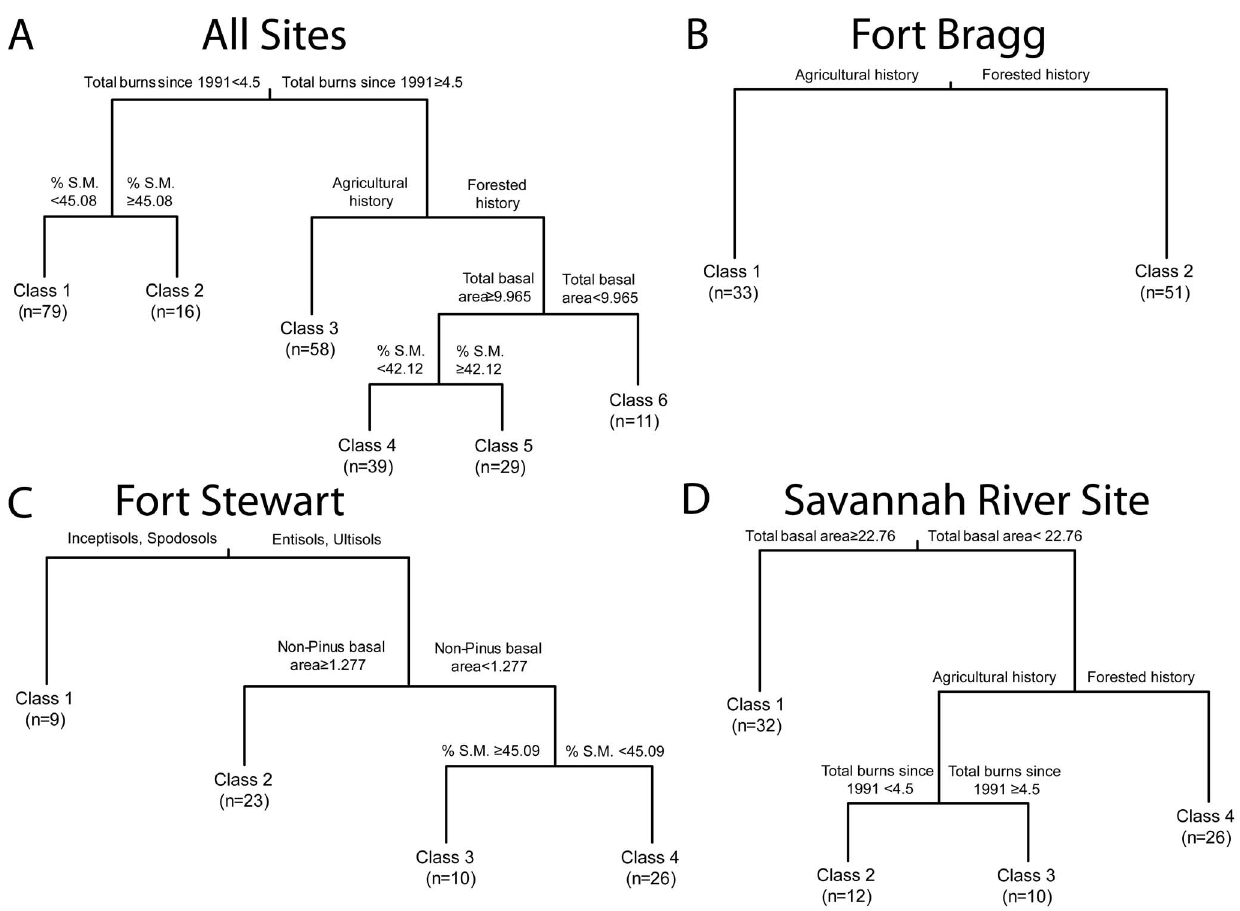
Figure 3. Results of multivariate classification and regression tree analysis. A) All study sites, B-D) separate study locations. In each analysis, sites are classified based on plant community composition and environmental data and classes are ordered to align with the conceptual model in Figure 1 (Class 1= most degraded), with the exception of Class 1 at Fort Stewart, which represents a soil-vegetation association not related to degradation. Branch length at each split is scaled to the variance explained by the corresponding environmental factor. The number of study sites in each class is presented below each class label.